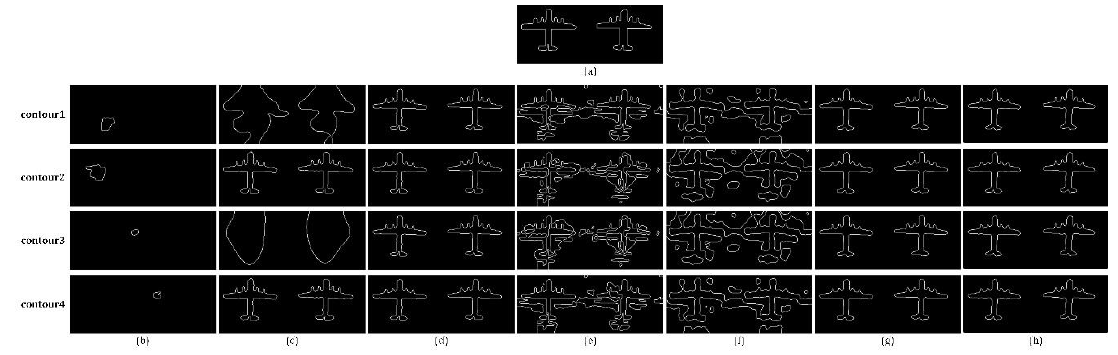
Figure 20. Boundary maps of ‘man’ image: ( a ) ground truth; ( b ) GAC; ( c ) CV; ( d ) SBGFRLS; ( e ) LBF; ( f ) ILFE; ( g ) Cao’s model; ( h ) the proposed method. Remote Sens. 2018 , 10 , x FOR PEER REVIEW 36 of 39